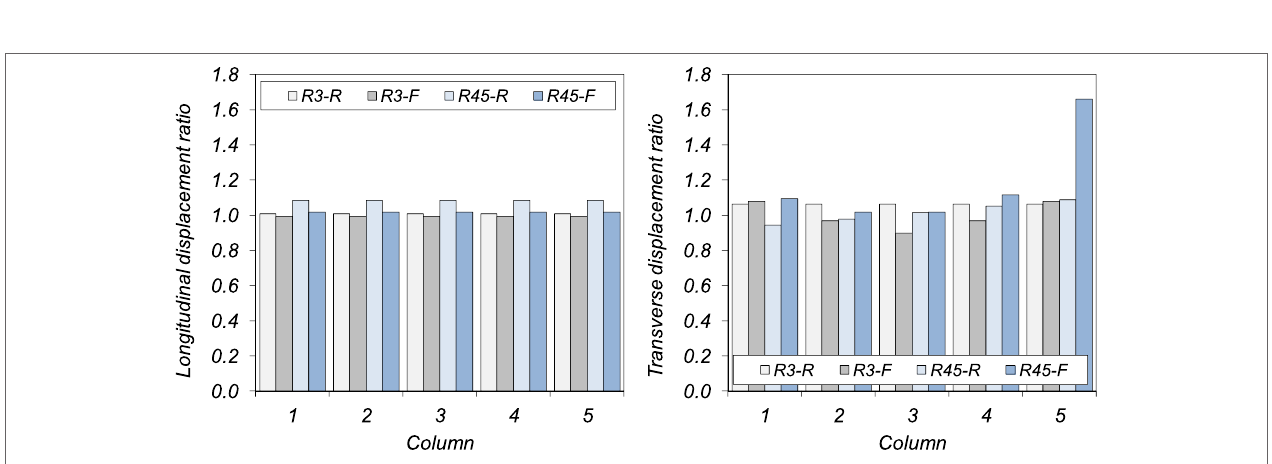
FigUre 13 | Column tip displacement ratio between the case study with the crane mass and R0. The column number refers to Figure 11a . The R0 reference values are 196 (233) mm for all the columns in the longitudinal direction for the flexible (rigid) roof, and 98 (136) mm, 156 (136) mm, 156 (136) mm, 156 (136) mm, and 98 (136) mm for each column (1–5) in the transverse direction for the flexible (rigid) roof.